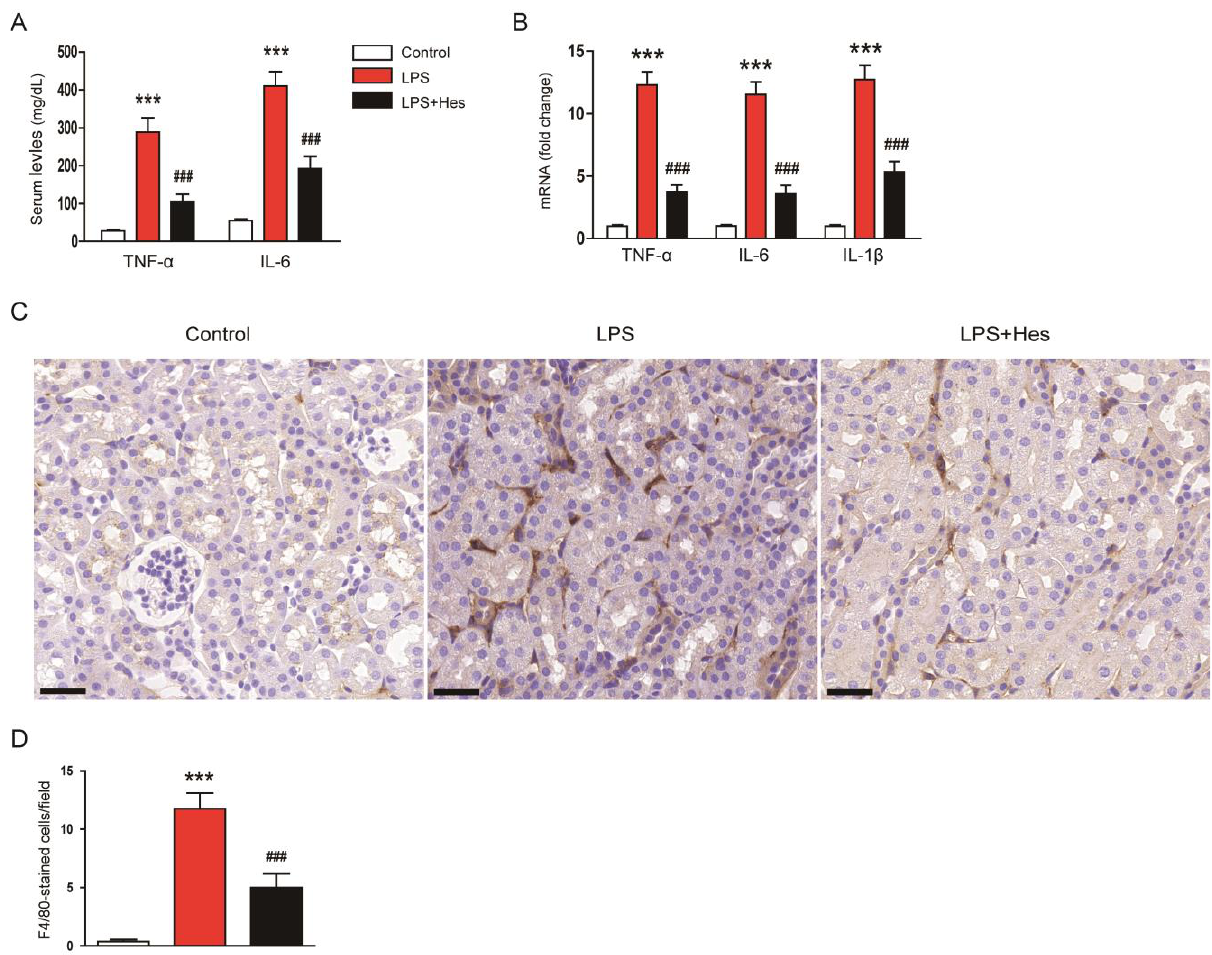
Figure 7. Hesperetin mitigated LPS - induced inflammatory responses. ( A ) Serum tumor necrosis factor - α (TNF - α) and interleukin - 6 (IL - 6) levels. ( B ) Renal mRNA expression of TNF - α, IL - 6, and IL - 1β. ( C ) IHC staining for F4/80. Scale bar: 30 μm. ( D ) Number of F4/80 - positive cells per field. n =